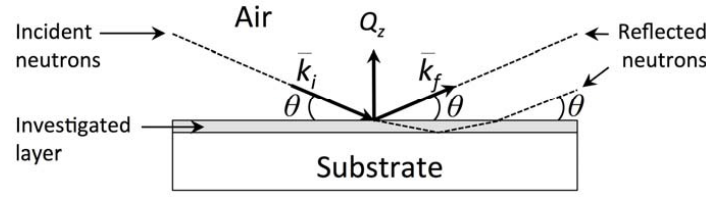
Figure 1. Schematic of a neutron reflectometry measurement.